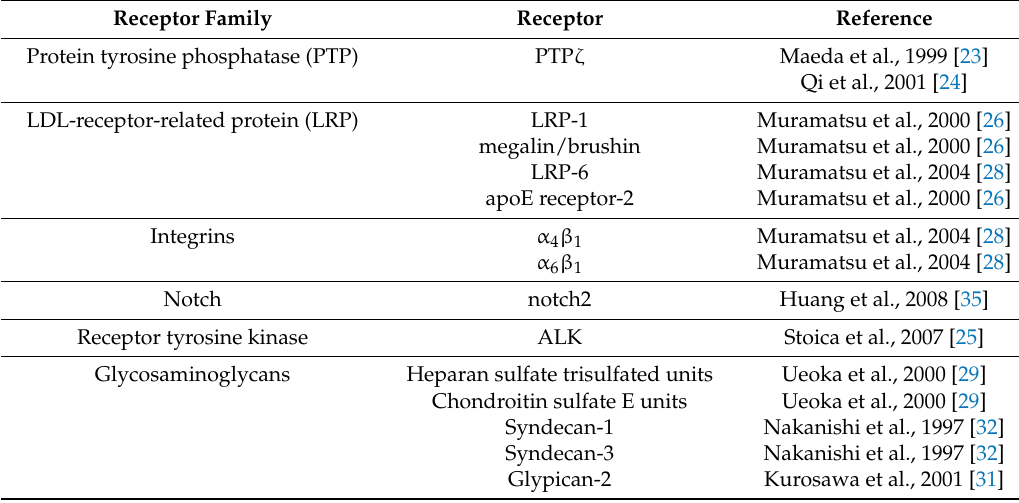
Table 1. Midkine